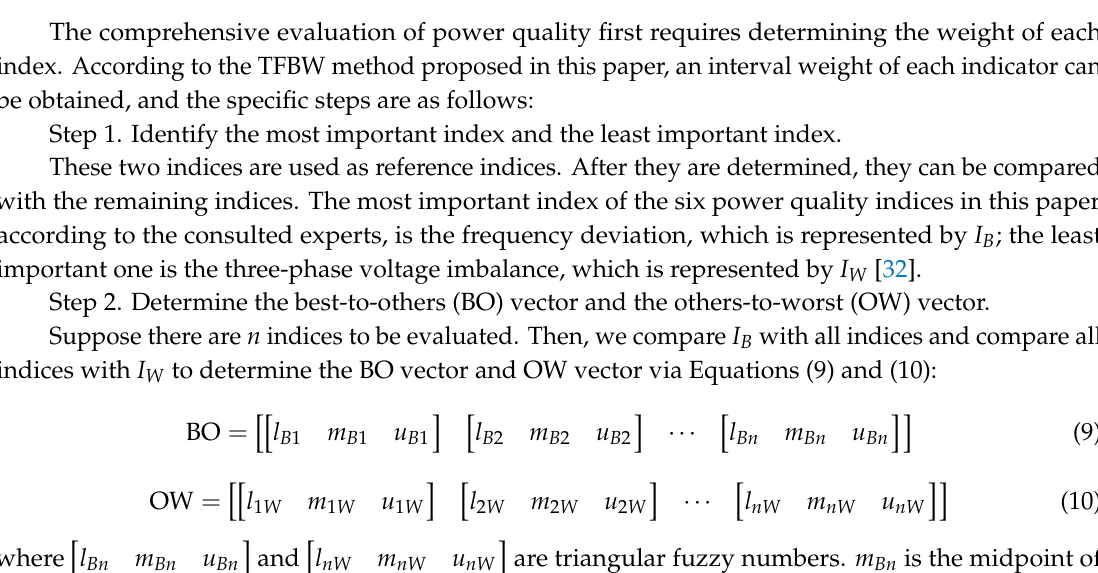
Figure 3. Comparison importance of index by best–worst (BW) method.